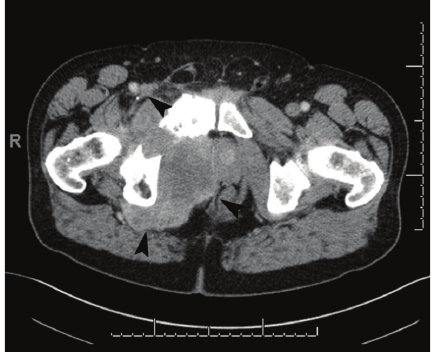
Figure 4: Axial CT of the pelvis (February 2015) showed severe interval enlargement of the soft tissue mass (arrows) surrounding the right inferior ramus (soft tissue algorithm).